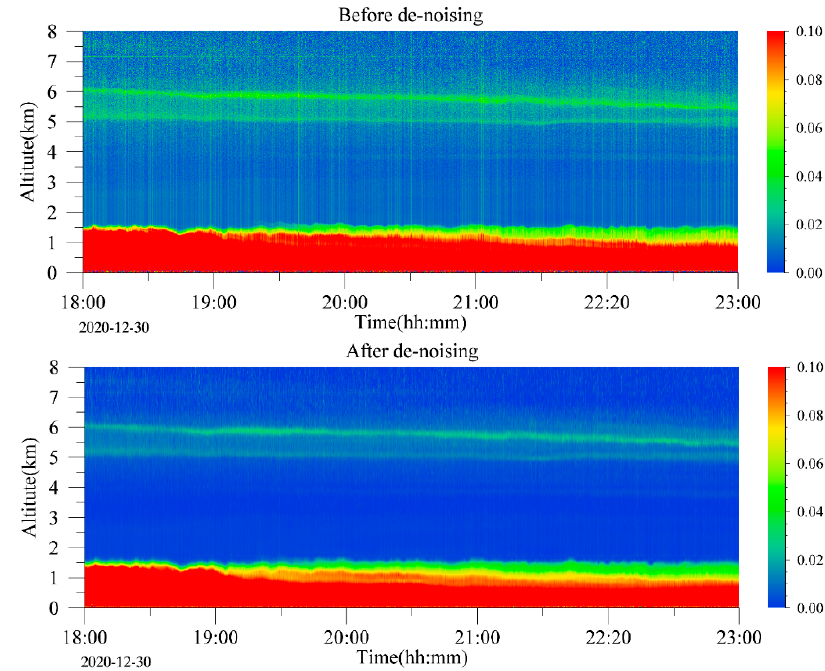
Figure 11. Comparison of aerosol extinction coefficient before and after denoising.